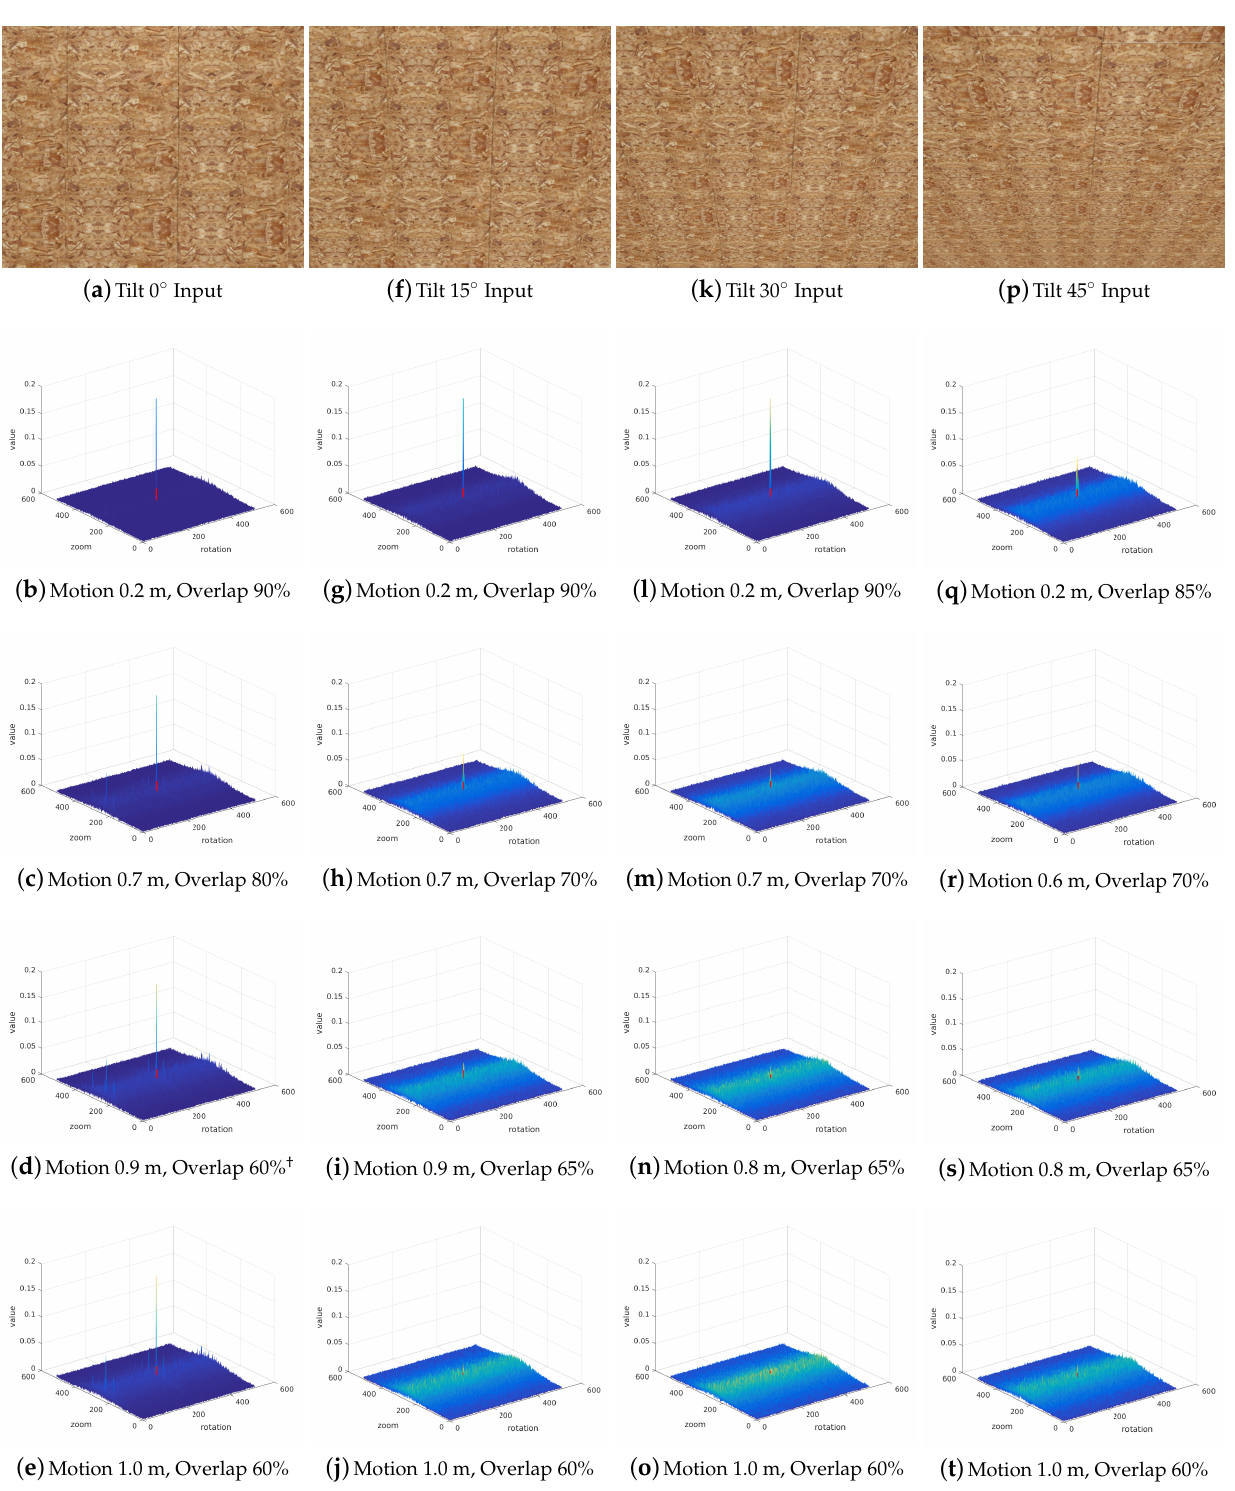
Figure 17. Rotation and zoom PSDs with different tilt angles and camera motions. The angle between the plane and the imaging plane changes from 0 ◦ to 45 ◦ . Each column corresponds to one angle. When the angle is not 0 ◦ , it is a slanted plane in the view, leading to continuous depths. The distance between the camera and the slanted plane is about 3 m. † The overlap is smaller than others in this row due to the bigger motion in u -direction of the